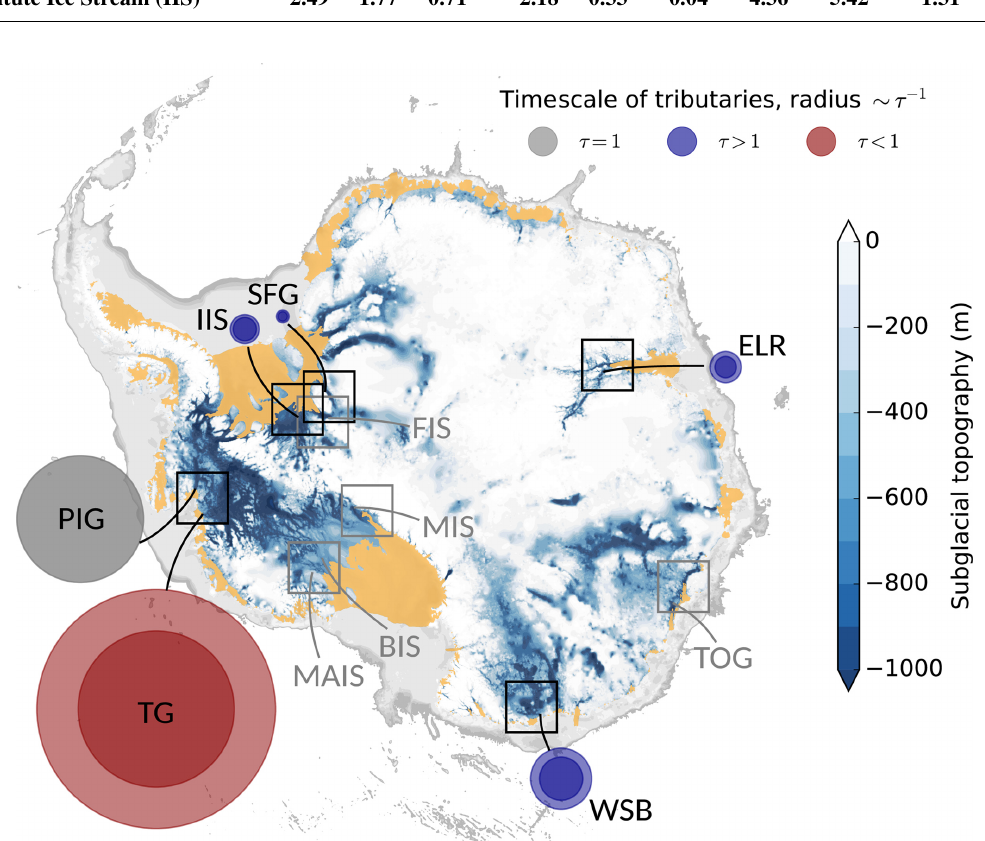
Figure 4. Map of inverse response time of Antarctic tributaries (two circles for each, corresponding to the two independent estimates, τ and e τ ; see Table 1) relative to Pine Island Glacier (grey circle) as obtained from similitude analysis. Rectangles denote examined regions as displayed in (Figs. 2 and S1–S9). Regions discarded from the analysis are shown in grey. Shown are (clockwise) Pine Island Glacier (PIG), Thwaites Glacier (TG), MacAyeal Ice Stream (MAIS), Bindschadler Ice Stream (BIS), Mercer Ice Stream (MIS), Wilkes Subglacial Basin (WSB), Totten Glacier (TOG), East Lambert Rift (ELR), Support Force Glacier (SFG), Foundation Ice Stream (FIS) and Institute Ice Stream (IIS). Marine bed topography in blue (color bar), ice shelves in yellow and continental shelf in grey are taken from BEDMAP2 (Fretwell et al.,